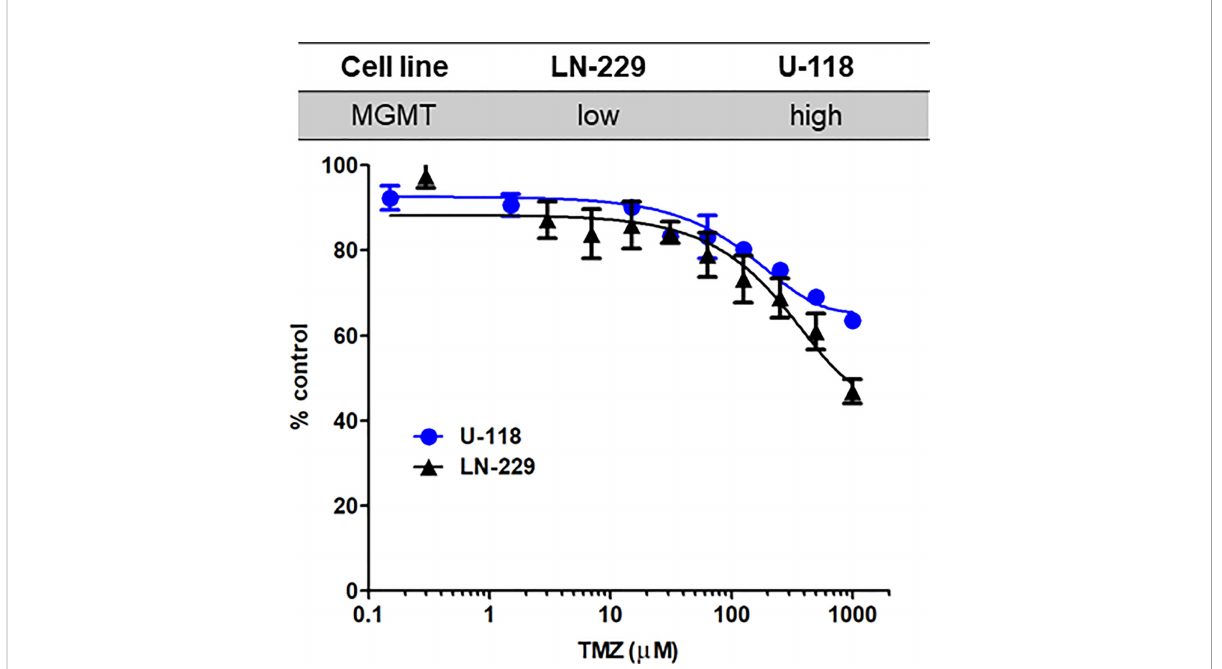
FIGURE 4 Susceptibility to TMZ in GBM cells with different MGMT expression levels. LN-229 (black triangle) and U-118 (blue circle) cells were exposed to various concentrations of TMZ for 72 hr. Dose-response curves for TMZ were determined by MTT assays. N=3 in each concentration. Mean ±